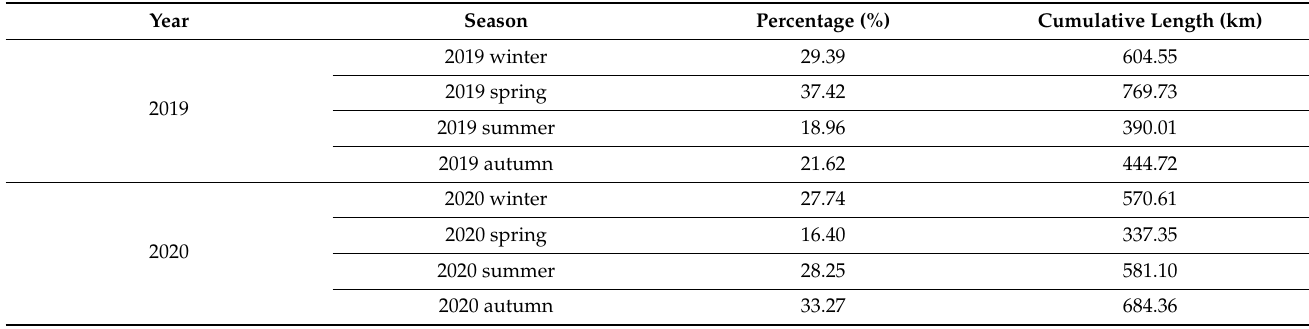
Table 2. The proportion of river for which water surface slope was calculated by